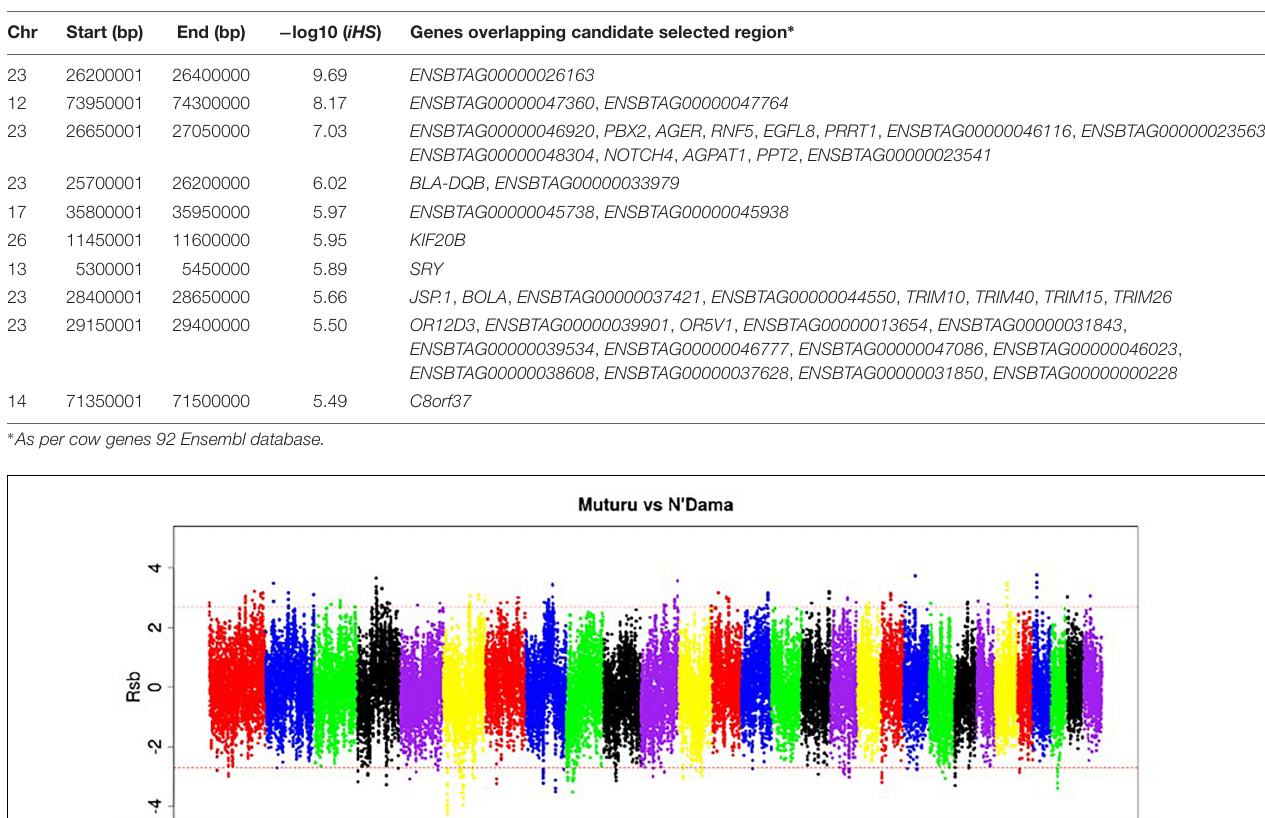
FIGURE 4 | Manhattan plot of the genome-wide distribution of iHS scores for the autosomes in Muturu cattle. The red dash line indicates the threshold of P < 0.0001 [equivalent of –log ( iHS ) > 4] at which windows are considered under selection. TABLE 2 | Most significant 10 iHS candidate selection signature regions in Muturu.